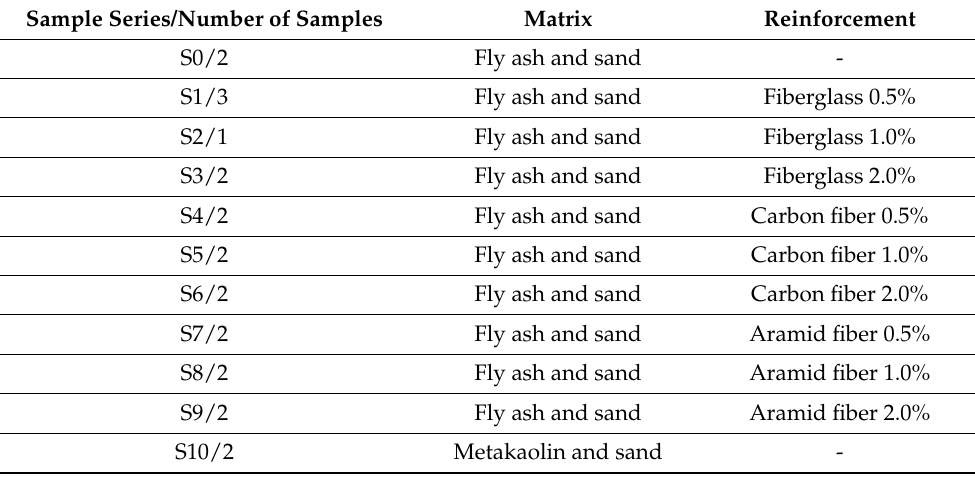
Table 2. Compositions of prepared geopolymer